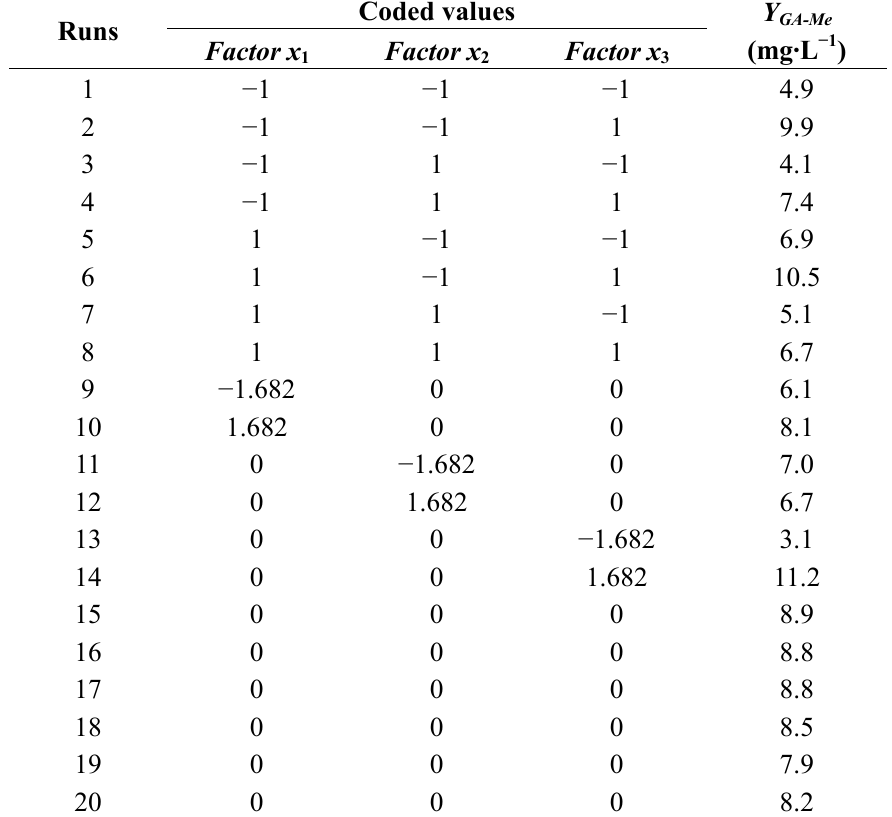
Table 2. The central composite design matrix and the response of ganoderic acid Me (GA-Me) of G. lucidum .